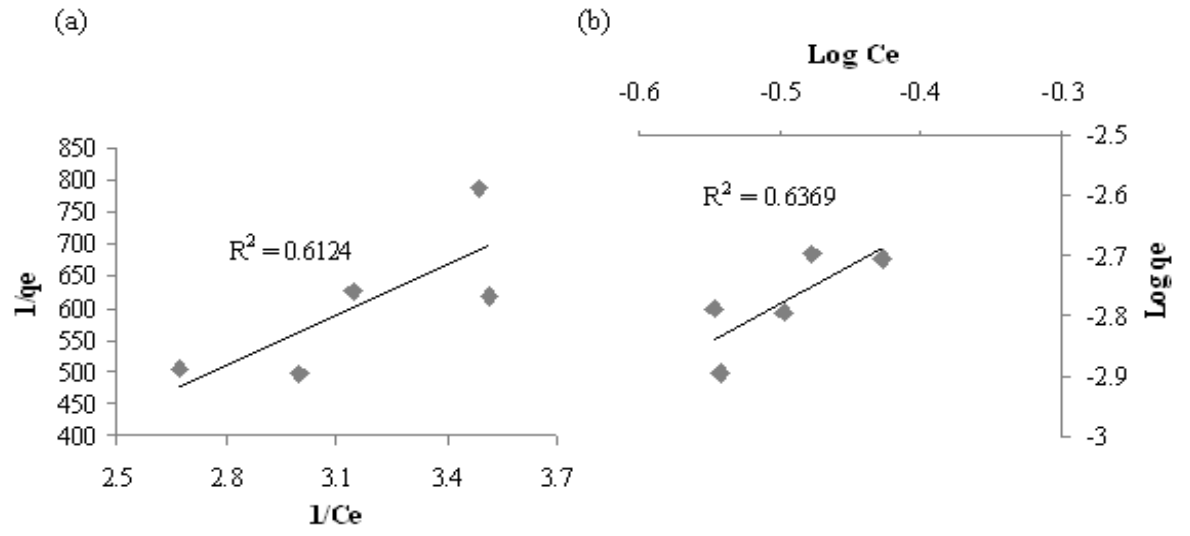
Figure 6. Adsorption isotherm for zinc onto silica sand at: ( a ) Langmuir and ( b ) Freundlich.